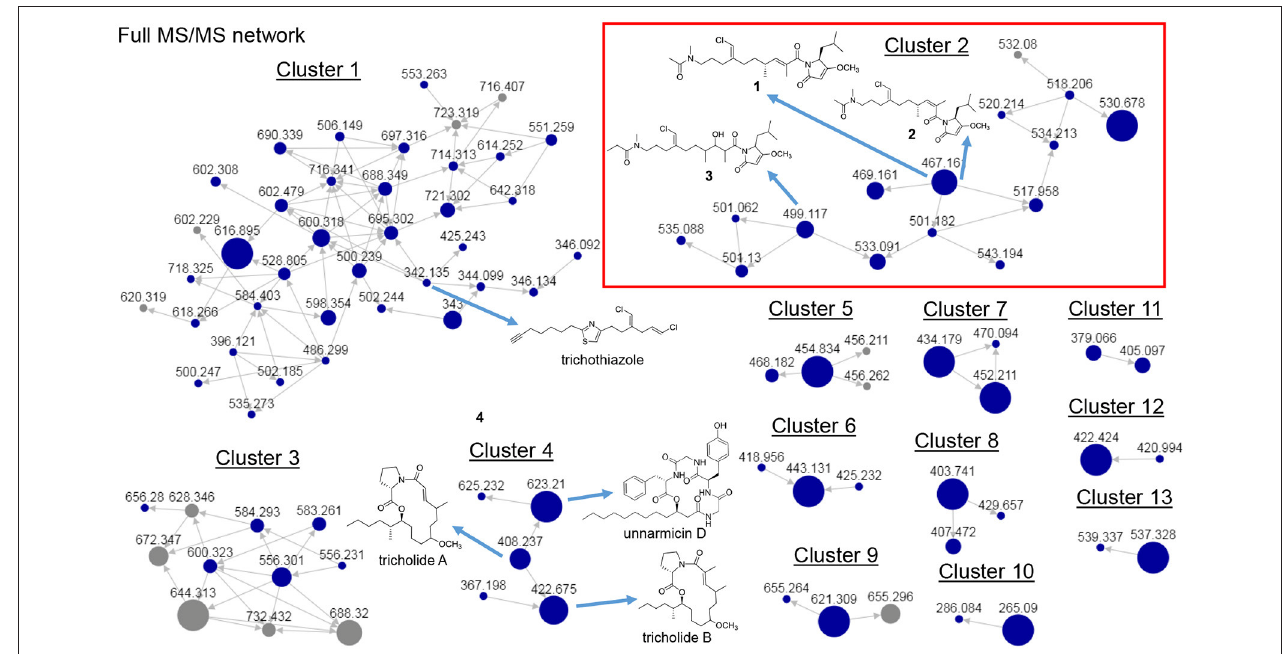
FIGURE 3 | MS/MS-based molecular networking cluster identifying 1–3 and smenamides A or B. Nodes are labeled with parent m/z values. Edges are labeled with cosine scores. Node size is relative to ion count.